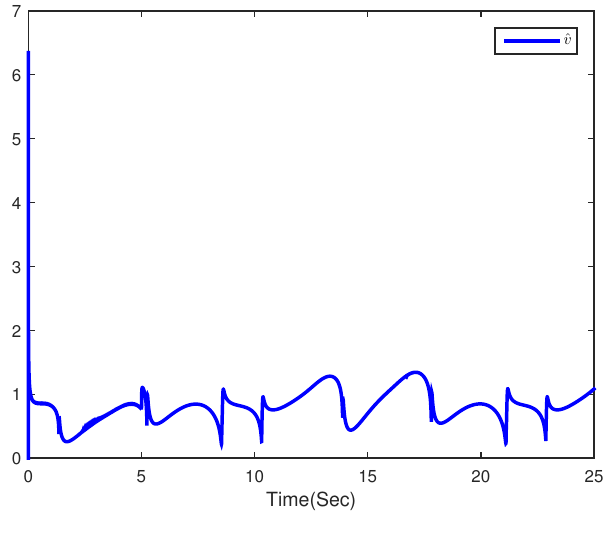
Figure 3. The curve of ˆ v (Case 1).